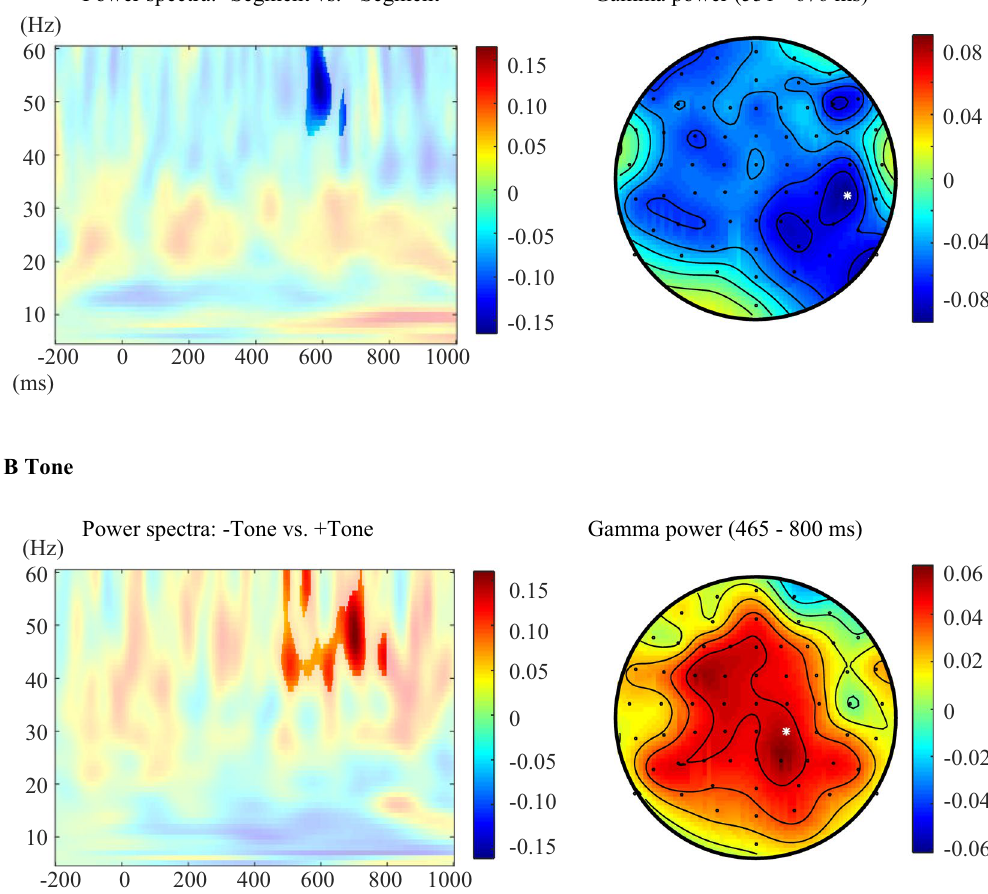
Figure 3. Results of time-frequency analyses in the Chinese experiment. ( A ) Time-frequency representations of the contrast + Segment minus − Segment at the CP6 electrode with a statistical mask (left); the topography of gamma frequency range from 531 to 676 ms with the white star marking the location of the CP6 electrode (right). ( B ) Time-frequency representations of the contrast + Tone minus − Tone at the CP2 electrode with a statistical mask (left); the topography of gamma frequency range from 465 to 800 ms with the white star marking the location of the CP2 electrode (right). The colour scale indicates the relative power changes (0 = no